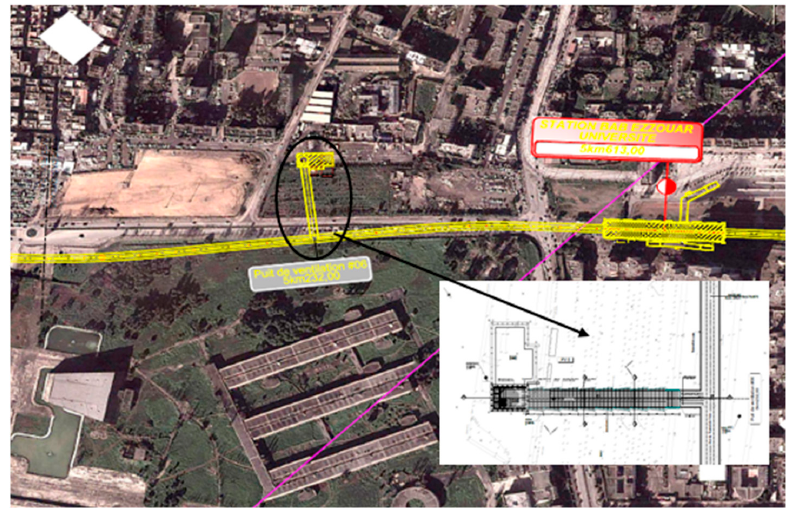
Figure 2. Location of the cross passage 6 in the Algiers metro project, Algeria.